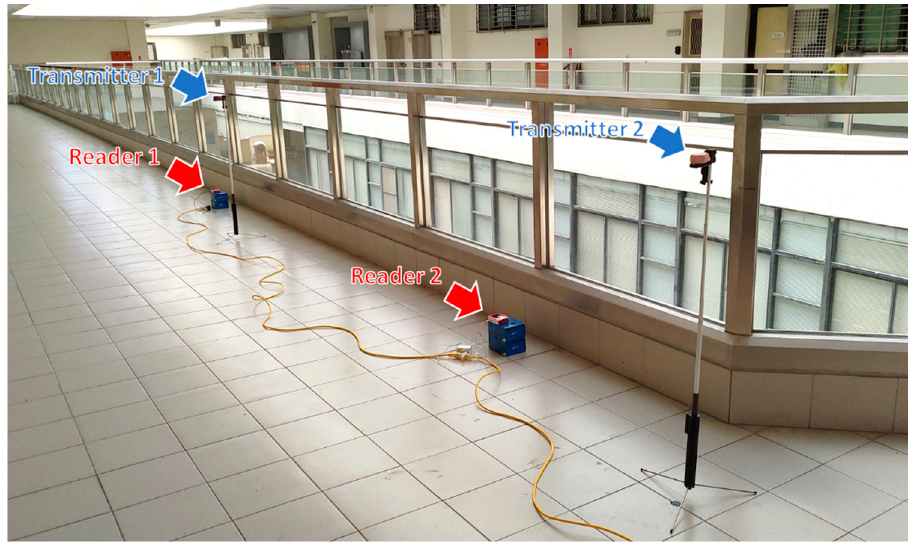
Figure 7. Environment for the experiments.